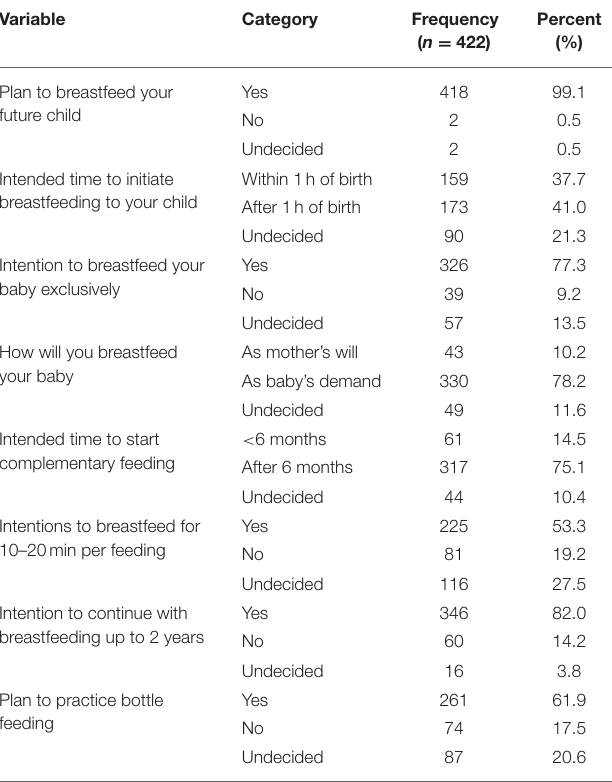
TABLE 3 | Breastfeeding intention among pregnant women attending the MCH clinic of DTCSH in Debre Tabor, Northwest Ethiopia, 2022.